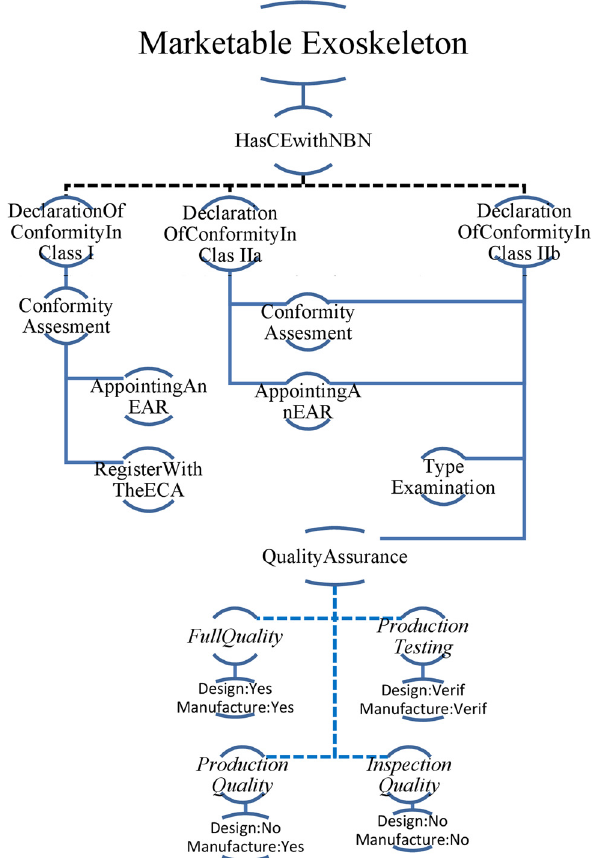
Figure 2: Class - based requirements for exoskeleton